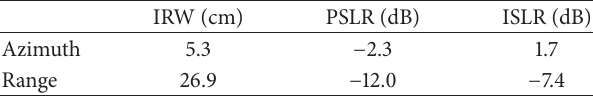
Table 4: SISO SAR performance for imaging